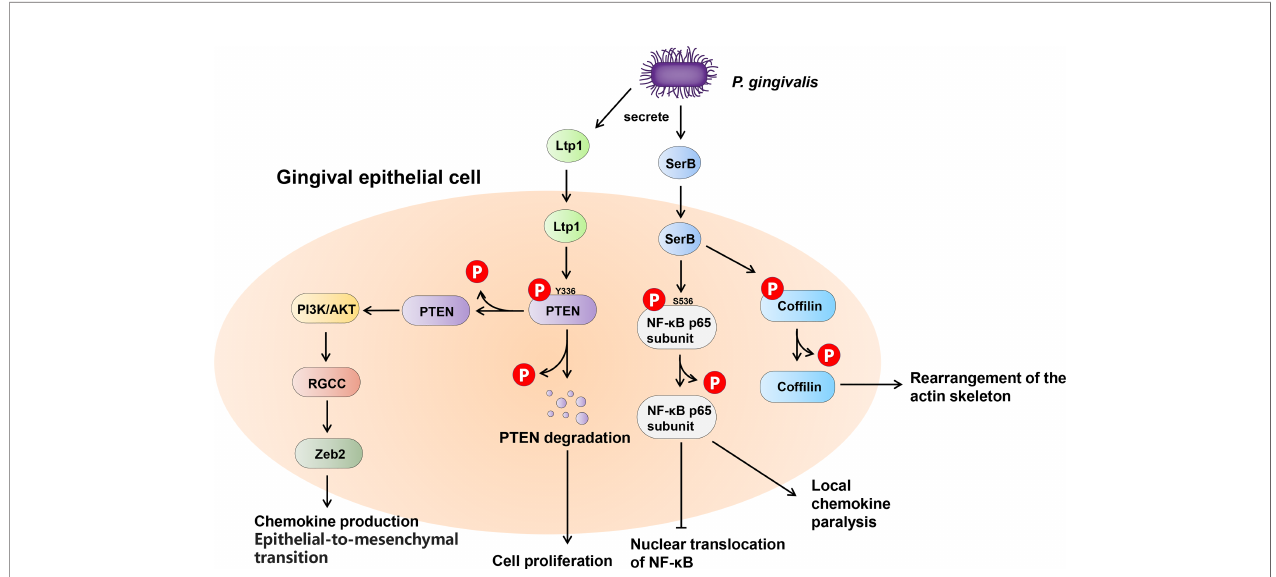
FIGURE 5 | Schematic of the impact of phosphatases secreted by Porphyromonas gingivalis within the gingival epithelial cells. P. gingivalis secretes two phosphatases, tyrosine phosphatase Ltp1 and serine phosphatase SerB. Upon contacting the gingival epithelial cell, Ltp1 enters the cell to dephosphorylate PTEN, causing proteasomal degradation. Lower PTEN levels promote the PI3K/AKT pathway to upregulate RGCC and Zeb2. SerB dephosphorylates NF- k B and Co fi lin to preserve the virulence of P. gingivalis and maximize the intracellular invasion of